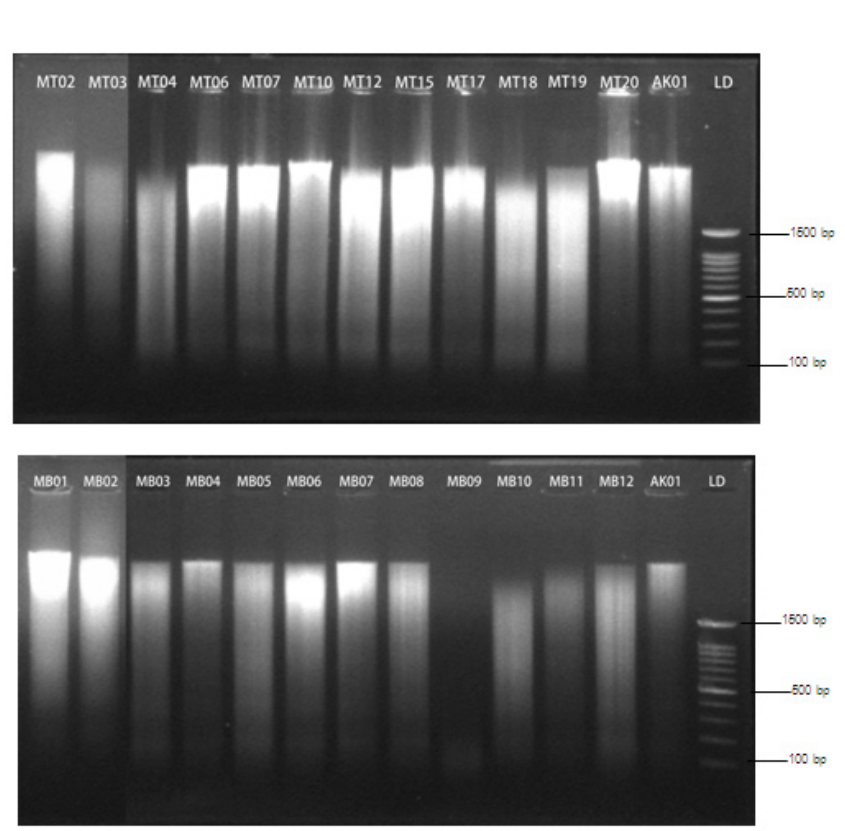
Figure 2. Gel visualizing DNA degeneration of eggshell membrane samples. Above: Tambun; Below: Tanjung Binereaan; LD: 100 bp DNA Ladder (SMOBiO); AK01: domestic chicken eggshell